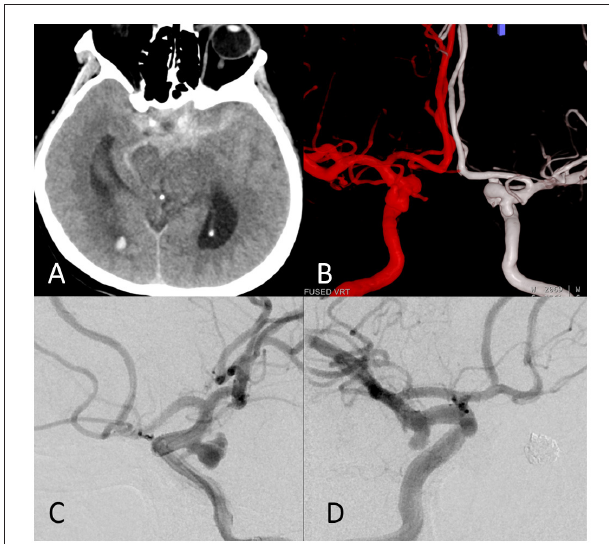
FIGURE 1 | The images of a representative ruptured mirror posterior communicating artery aneurysm (PComAA). A 67-year-old woman presented with a severe headache. (A) Brain computed tomography (CT) scan showed subarachnoid hemorrhage (SAH) more on the left side. (B) Dual fusion of three-dimensional-digital subtraction angiography (3D-DSA) revealed a mirror PComAA. The left side of the mirror PComAA was more irregular than the right side. (C) The left internal carotid artery angiography revealed an irregular posterior communicating artery aneurysm that was a ruptured aneurysm. (D) The right internal carotid artery angiography showed a regular posterior communicating artery aneurysm.